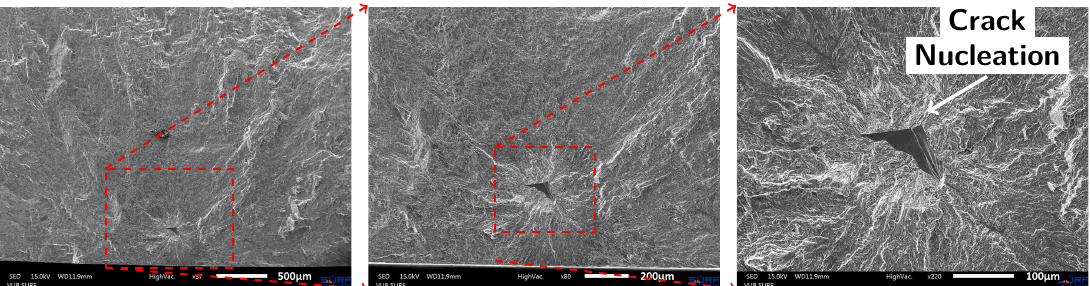
Figure 8. SEM images of the fracture surface of Specimen 7 (AM material without capillary). The fatigue crack initiated from an internal defect near the bottom of the sample.